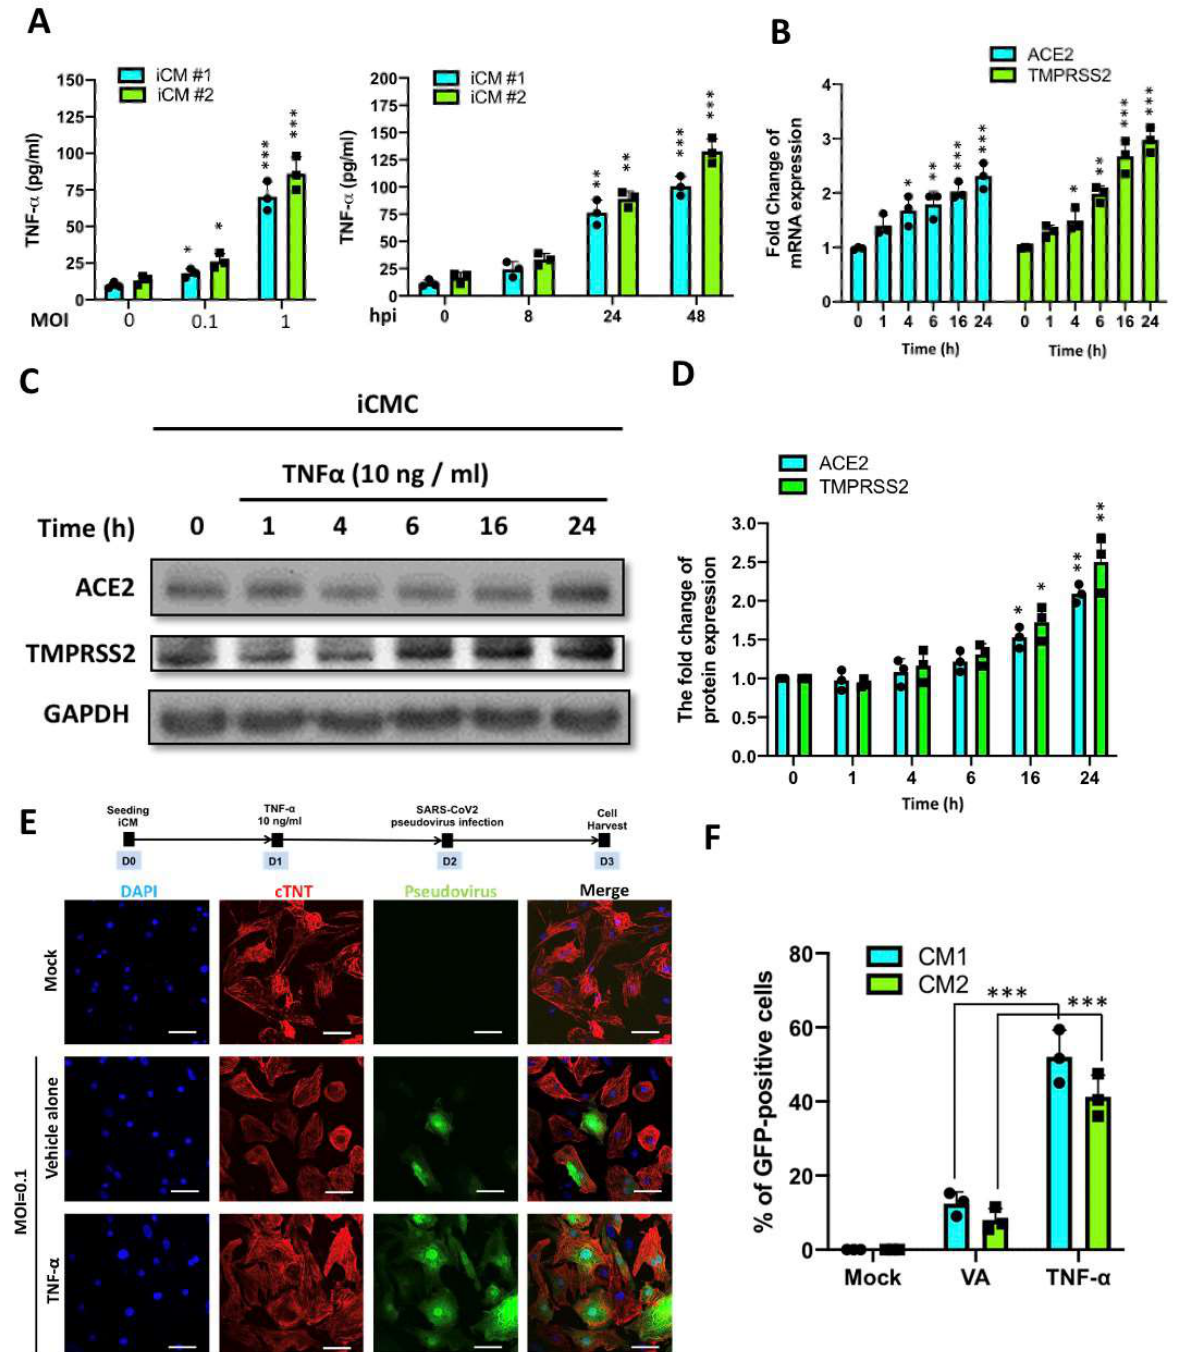
Figure 5. Effect of TNF-α on the entry of SARS-CoV2 pseudovirus in iCMs. ( A ) Effect of SARS-CoV2 infection on TNF-α secretion. iCMs were exposed to various MOI (left) of SARS-CoV2 or SARS-CoV2 (MOI = 1) for a different time, and then the secretion of TNF-α in the iCM culture was examined. ( B ) Quantitative real-time PCR showed that TNF-α (10 ng/mL) increased the gene expression of ACE2 and TMPRSS2 in iCMs in a time-related manner. * p < 0.05, ** p < 0.01, *** p < 0.001 vs. 0 h. ( C ) Western blot showed that TNF-α (10 ng/mL) increased the protein amount of ACE2 and TMPRSS2 in iCMs. ( D ) Quantifications of Western blots. ( E ) Upper panel: 24 h after seeding, iCMs were treated with TNF- α (10 ng/mL) for 24 h. After the TNF- α treatment, iCMs were infected with SARS-CoV2 pseudovirus. One day after the viral infection, iCMs were harvested and subjected to immunofluorescence staining. Lower panel: Immunofluorescence staining showed that the entry of SARS-CoV2 pseudovirus into iCMs was increased upon TNF- α treatment as compared with the treatment of the vehicle alone (VA). Scale bar = 50 µ m. ( F ) Quantification of the immunofluorescence results. *** p < 0.001 vs. vehicle